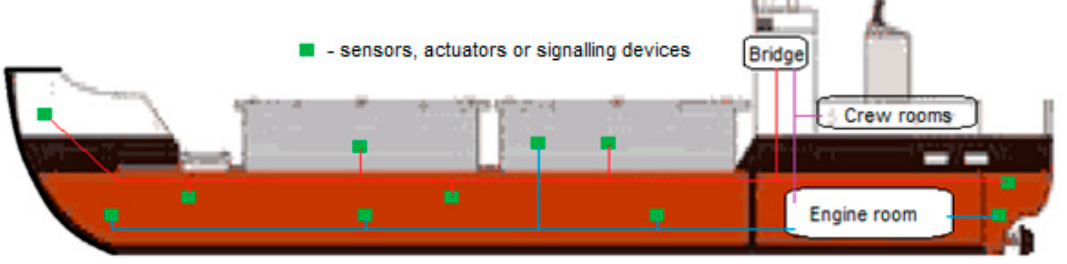
Figure 1. Overview sketch of communication connections on the ship.